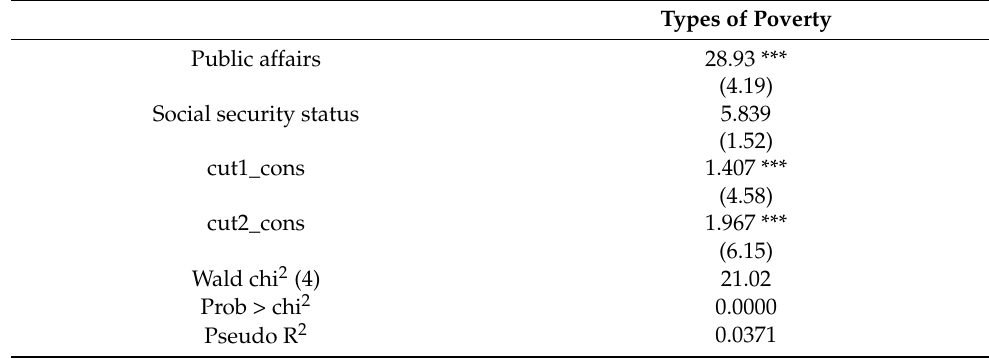
Table 5. Ordinal logistic regression results of impact of public affairs and social security status on different types of farmers.